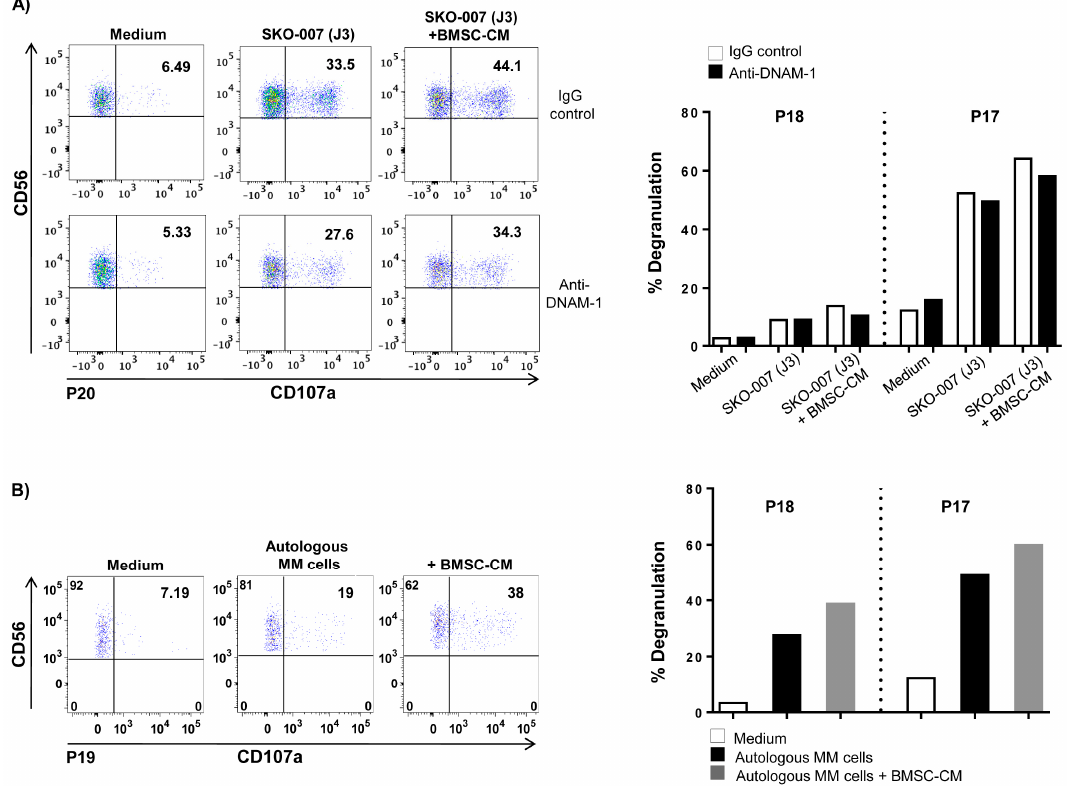
Figure 3. Patient-derived NK cell degranulation against BMSC-treated MM cells. CD138 − bone marrow Figure 3. Patient ‐ derived NK cell degranulation against BMSC ‐ treated MM cells. CD138 − bone cells were incubated with SKO-007(J3) ( A ) or autologous primary myeloma cells ( B ) untreated or treated marrow cells were incubated with SKO ‐ 007(J3) ( A ) or autologous primary myeloma cells ( B ) with BMSC-CM for 72 h and used as target cells in a degranulation assay. The assay was performed at the e ff ector: target (E:T) ratio of 2.5:1. After 3 h at 37 ◦ C, cells were stained with anti-CD45,